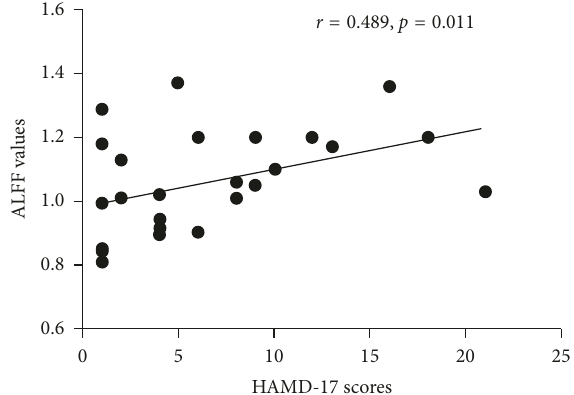
Figure 4: Correlation analysis between ALFF values in the right medial frontal gyrus and HAMD-17 scores. ALFF values in the right medial frontal gyrus affected by the interaction between groups and genotypes were positively correlated with HAMD-17 scores ( r 0.489, p 0 . 011) in the Gly carriers in the PD group. (cid:30) (cid:30) Abbreviations: PD, Parkinson’s disease; ALFF, amplitude of low- frequency fluctuations; HAMD, Hamilton Depression Scale.